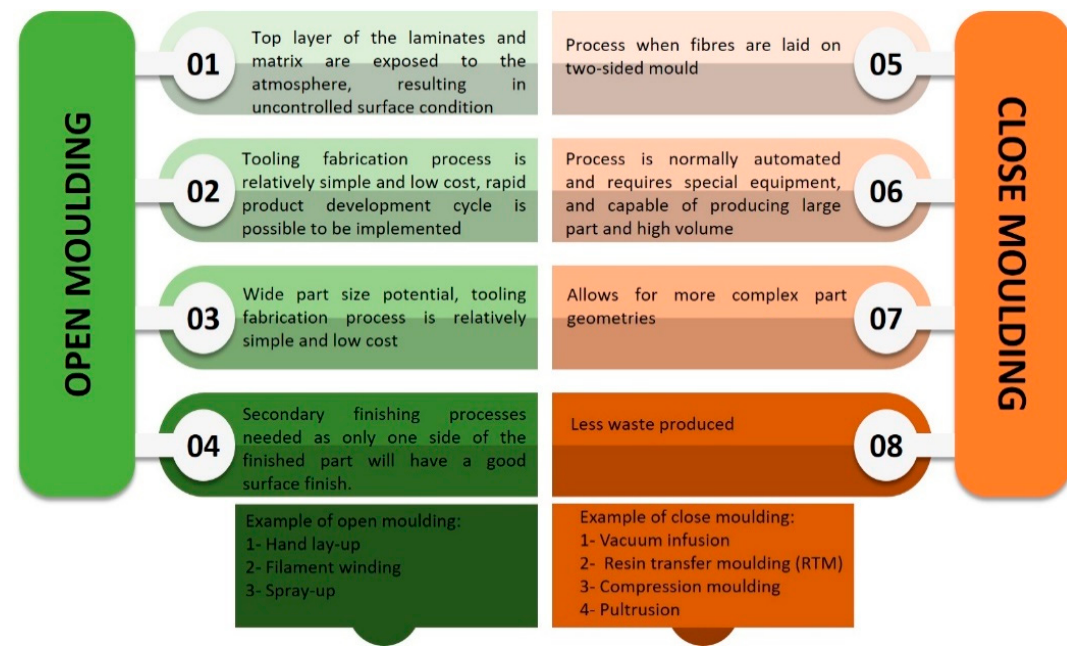
Figure 4. Comparison between open molding and closed molding.